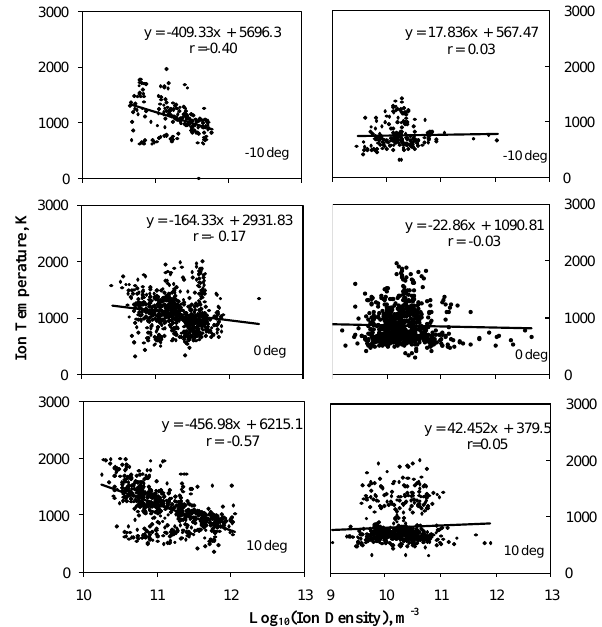
Fig. 4. Variation of daytime (left panel) and nighttime (right panel) ion temperature with corresponding ion density at − 10 ◦ , 0 ◦ and 10 ◦ magnetic latitude in the Indian longitude sector during low solar activity (1995 and 1996).